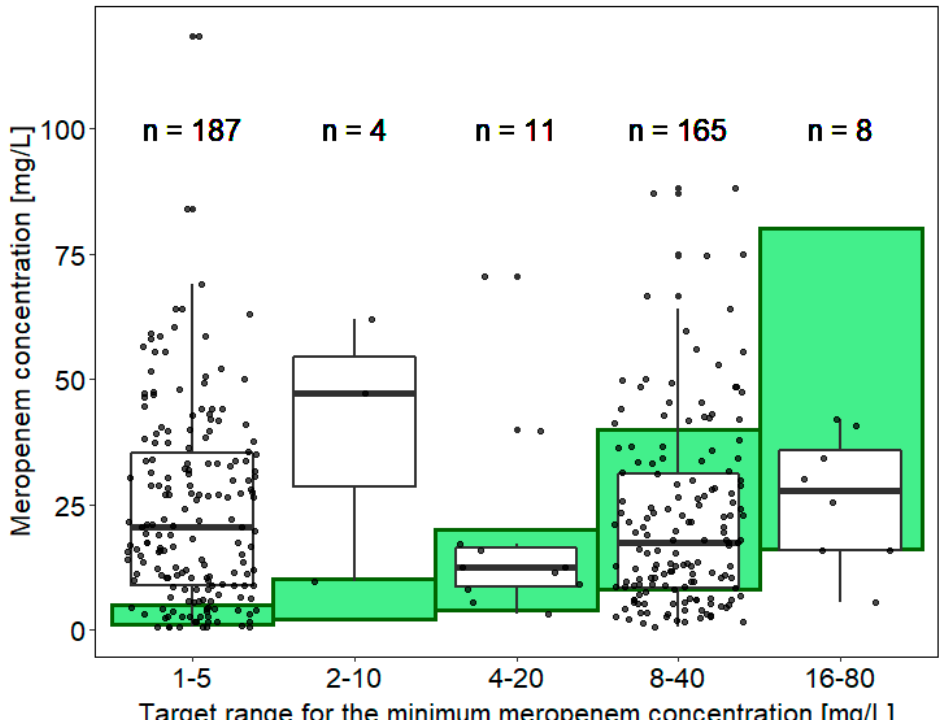
Figure A2. Boxplot of measured meropenem concentrations stratified by targeted drug concentration range. Target range (Green shaded areas) for the minimum drug concentration defined as 1–5 × MIC. If no MIC values could be determined an empirical target of 8–40 mg/L was used. Points: measured meropenem concentrations.